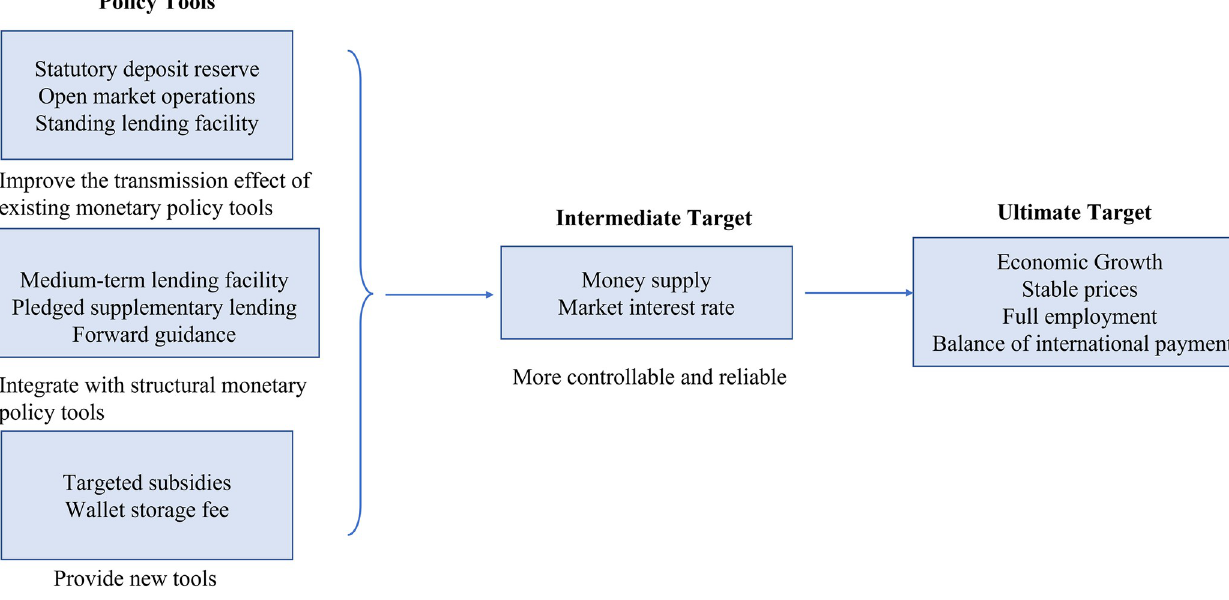
PLOS ONE | https://doi.org/10.1371/journal.pone.0268471 July 8,